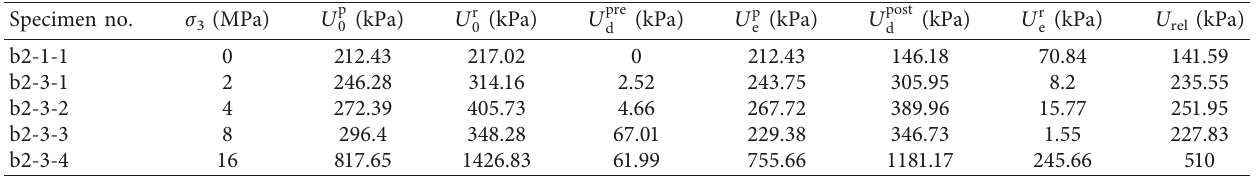
Table 6: The energy parameters under different confining pressures. Specimen